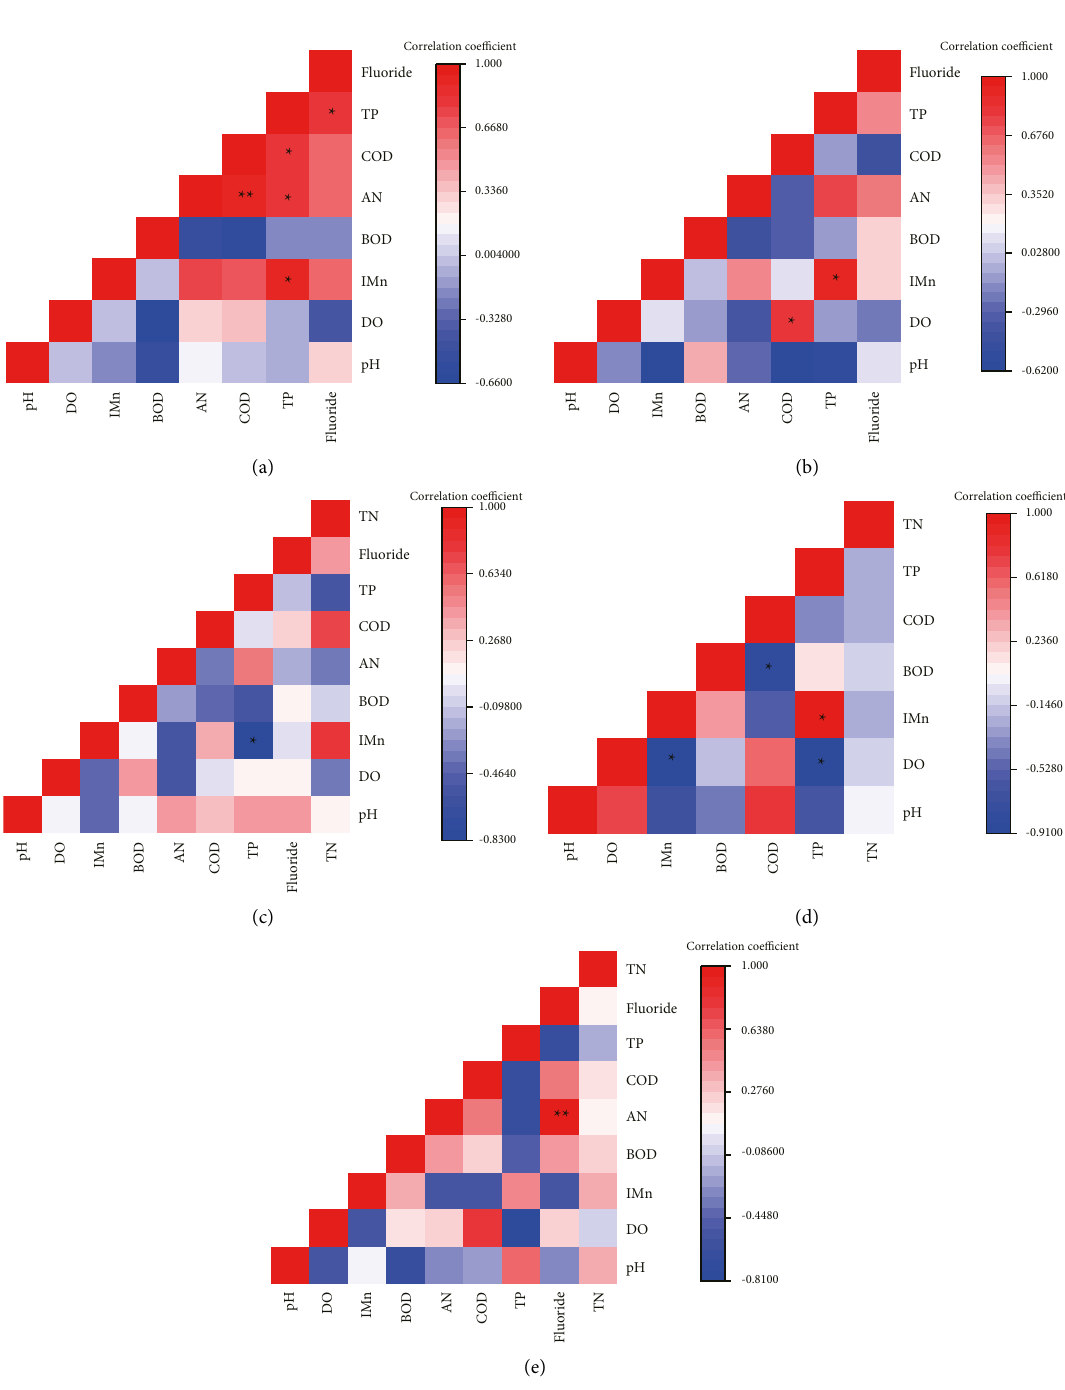
Figure 4: Correlation heatmap among the water quality parameters of the Ningxia section of the Yellow River during 2016–2020. (a) 2016; (b) 2017; (c) 2018; (d) 2019; (e) 2020. AN means